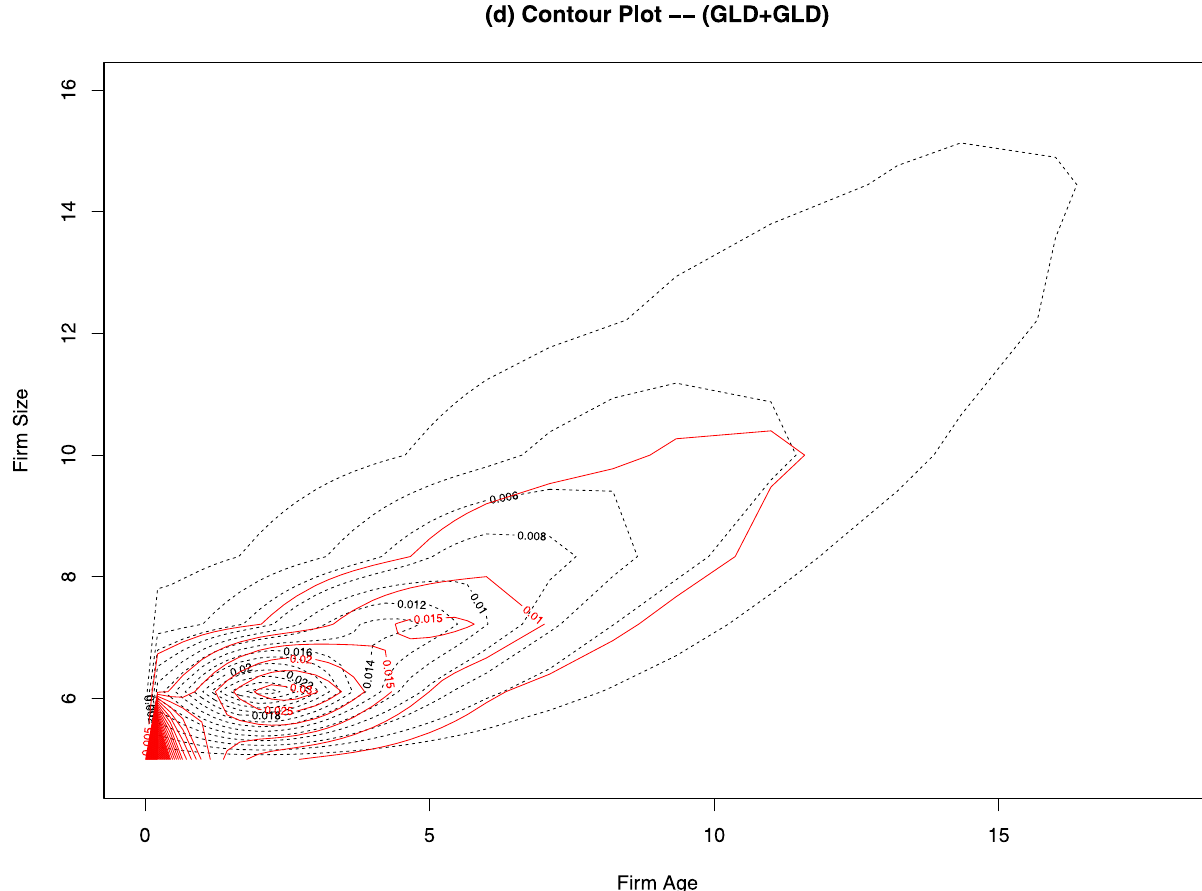
Fig 6. Estimated joint distribution of firm age and firm size for 2014 US private-sector firms without the first class. The dashed curves are the estimates using EWD for firm age and GLD for firm size. The solid red curves are the estimates using EWD for firm age and PD for firm size.